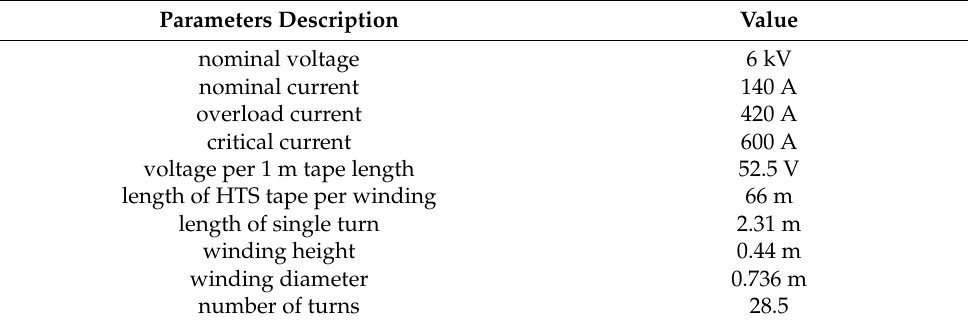
Table 1. Parameters of SFCL windings (2 × SF12100 HTS tapes) at 77.4 K